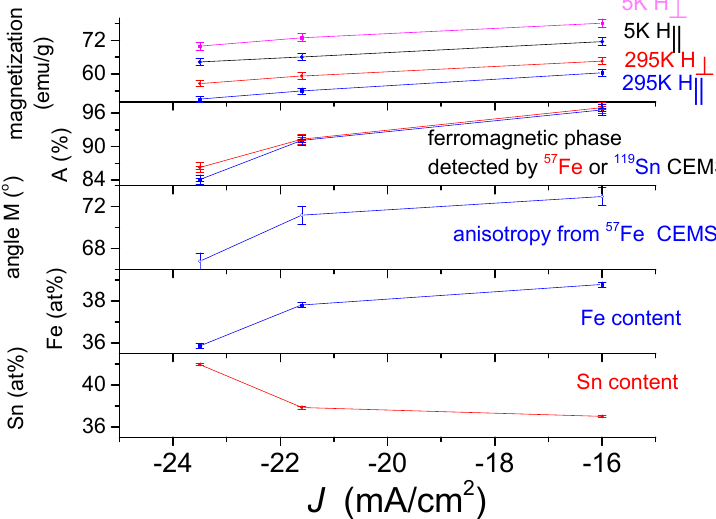
Figure 15. An extended scale of Figure 14 for the perpendicular susceptibility of PP1 sample.